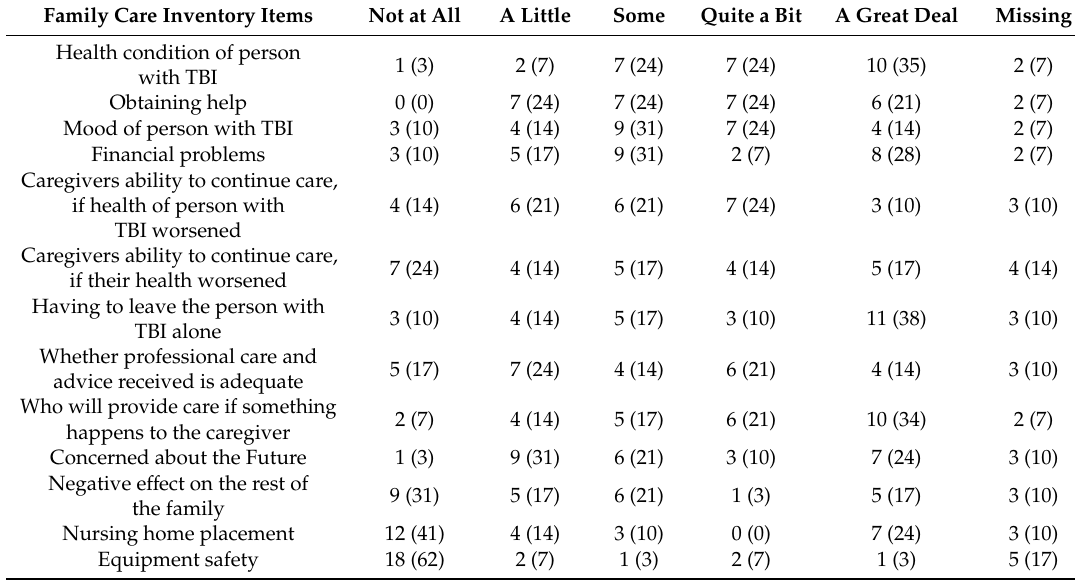
Table 3. Areas of concern reported by informal caregivers, as indicated by the Family Care Inventory ( n =